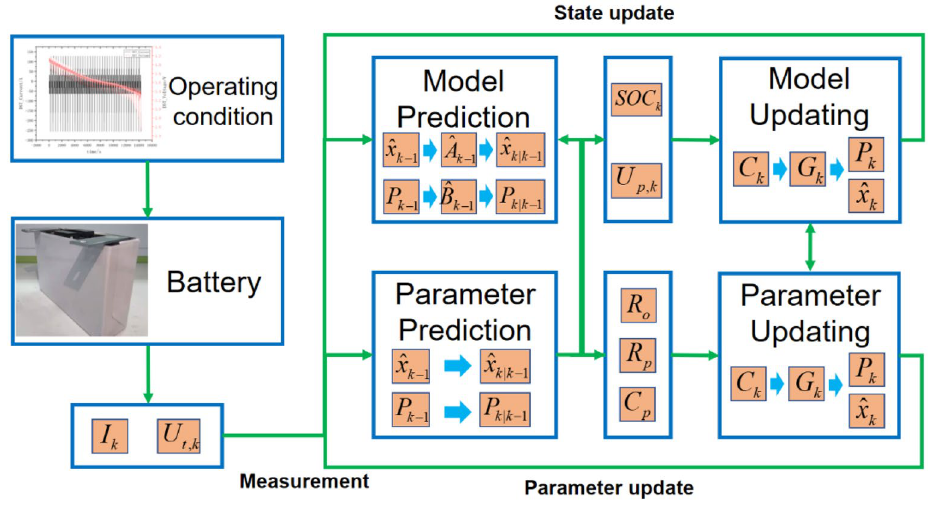
Figure 4. Process of online parameter identification.